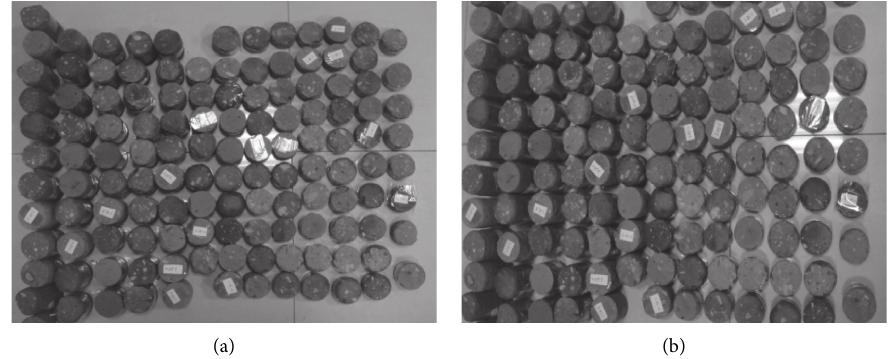
Figure 6: Part of standard samples for this test. (a) Standard sample of No. 3 hole. (b) Standard sample of No. 4 hole.